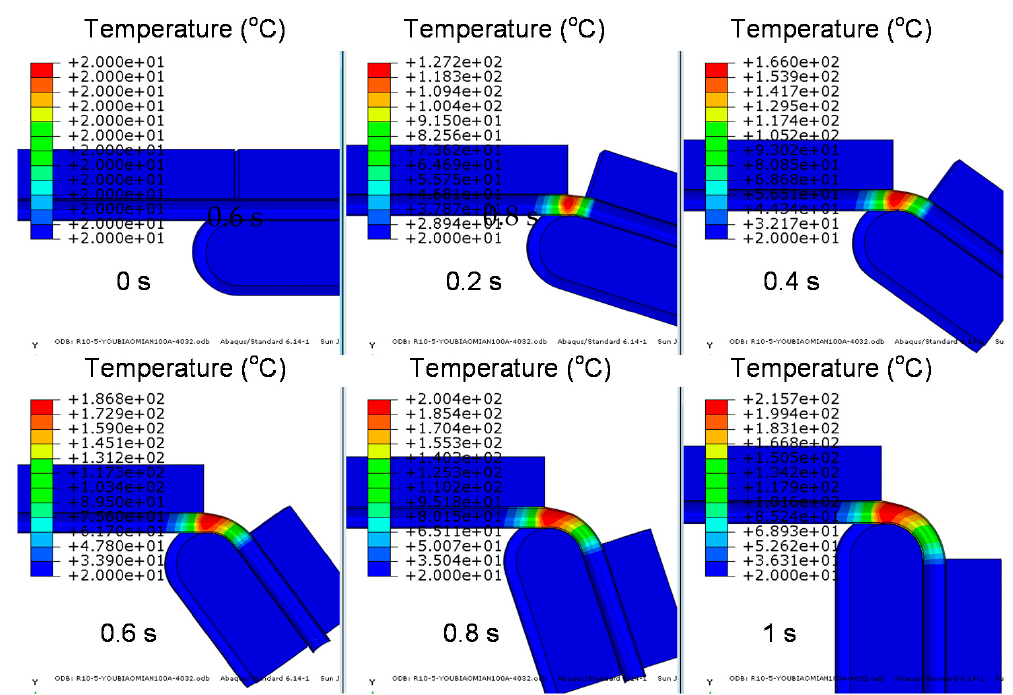
Figure 3. Evolution of Joule heating temperature distribution with time in micro-tube during EA RDB process.